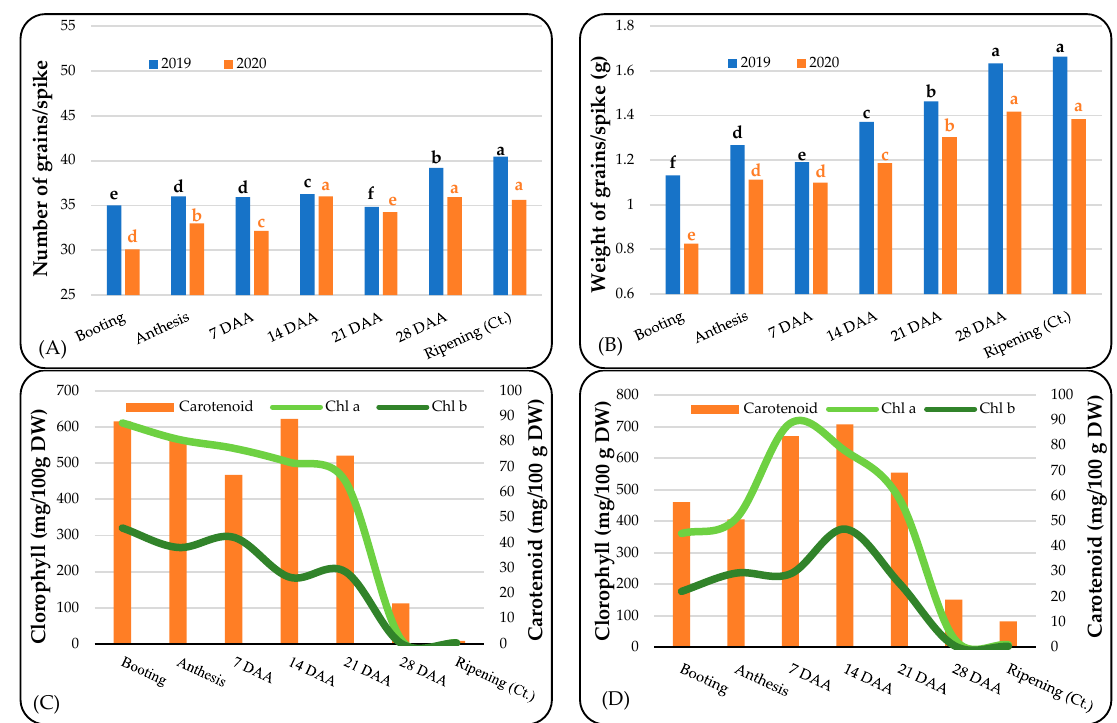
Figure 2. The variation of morpho–biochemical traits of Ciprian variety to different flag leaf removal times ( A , B ) number of grains/spike, respectively weight of grains/spike; ( C , D ) photosynthetic pigments-2019, respectively 2020. Different letters in ( A ) and ( B ) figures, the significance is represented according to Duncan Test.